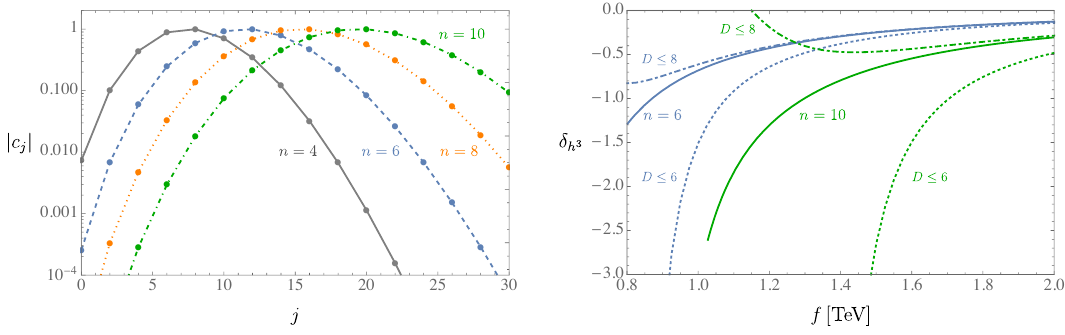
Figure 4 . Left: the magnitude of the coefficients in the expansion of the Gegenbauer potential, eq. (4.3), for various choices of n . Right: corrections to the Higgs self-coupling for n = 6 and 10 (solid lines), as compared to the results found from dimension-6 (dashed) and dimension-8 (dot-dashed) truncations of the full